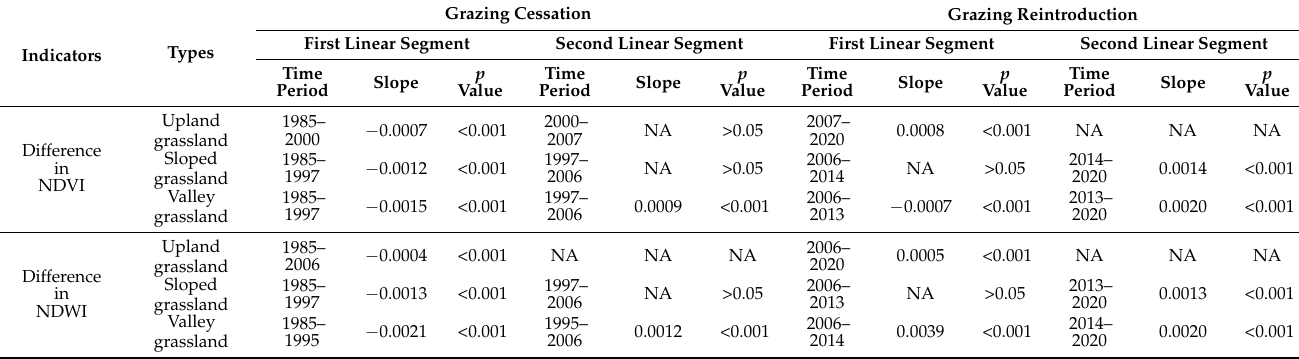
Figure 4. The temporal trends of the difference in Normalized Difference Vegetation Index (NDVI) and Normalized Difference Water Index (NDWI) between Grasslands National Park (GNP) sites and surrounding pastures. ( a – c ) are the temporal trends of the difference in NDVI for upland, sloped, and valley grasslands, respectively; ( d – f ) are the temporal trends of the difference in NDWI for upland, sloped, and valley grasslands, respectively. Table 4. The impact of grazing cessation and reintroduction on three native prairie types using NDVI and NDWI as indi- cators.